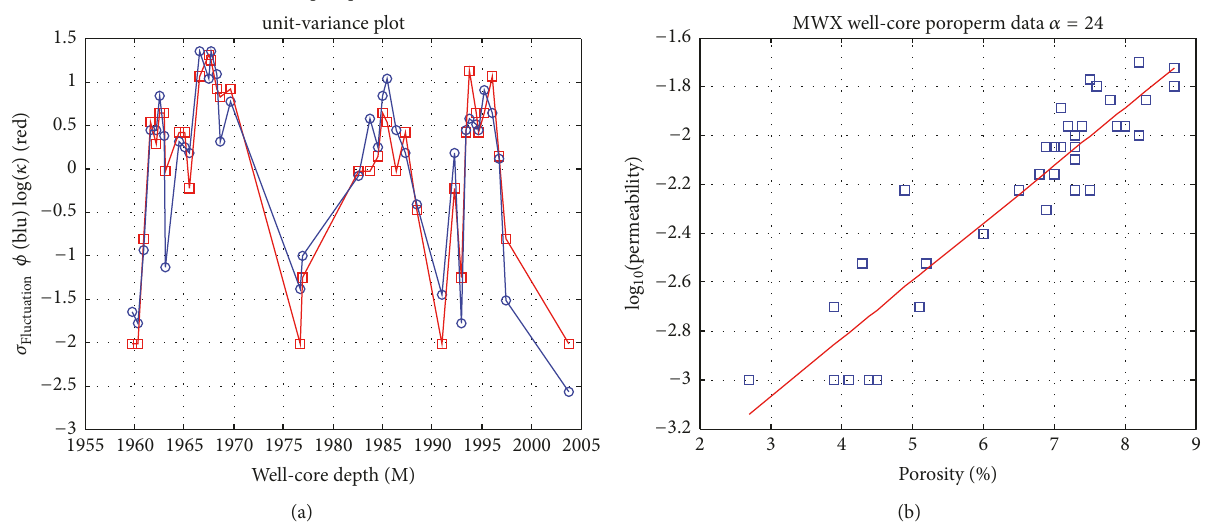
Figure 3: (a) MWX empirical property (6): spatially correlated well-core porosity (blue) and logarithm of well-core permeability (red); poroperm data normalized to zero-mean/unit-variance. (b) MWX empirical property (7): well-core porosity against log(permeability) (blue) with best-fit slope for 𝛼 ∼ 24 (red).